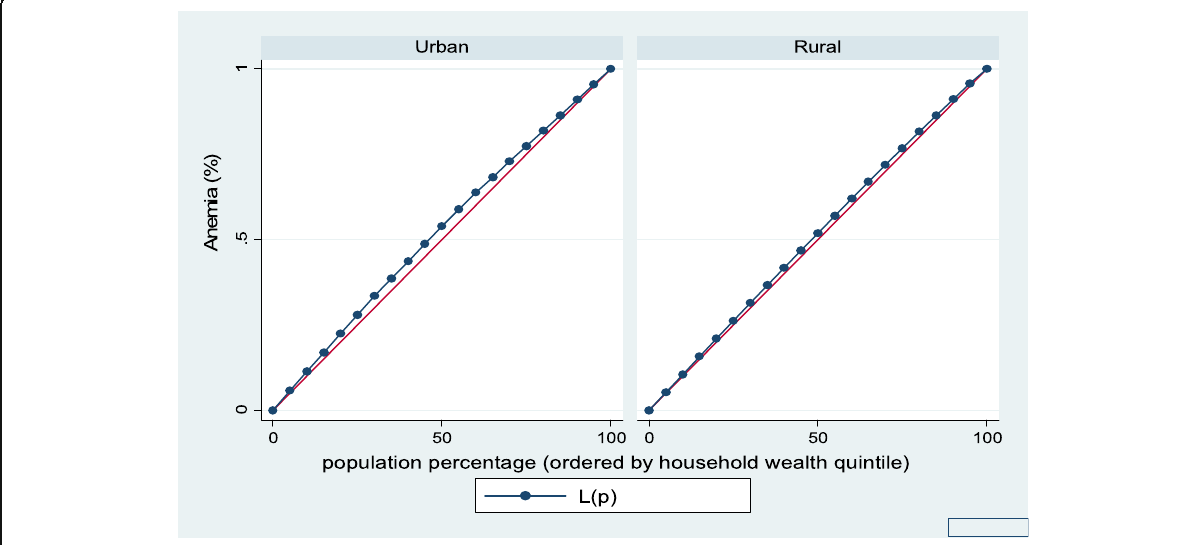
Fig. 5 Urban-rural Lorenz curve for anemia